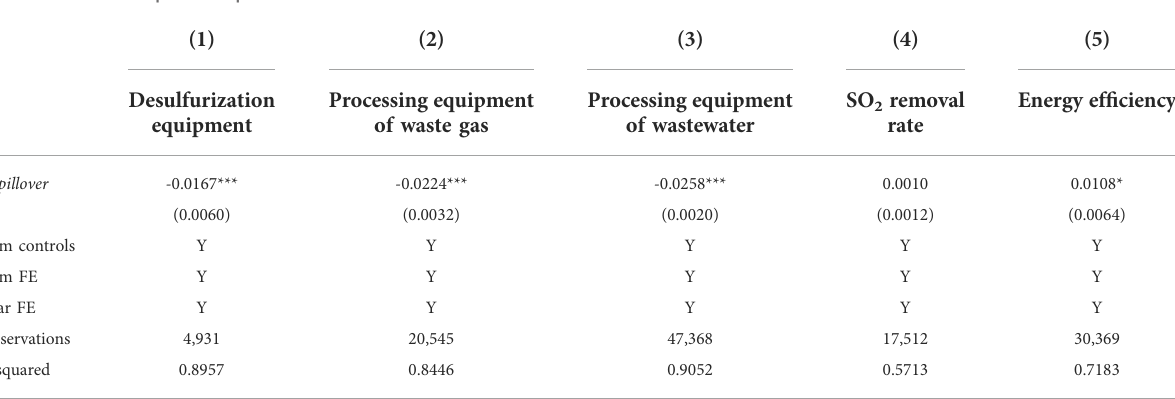
TABLE 7 Mechanism: pollution prevention and